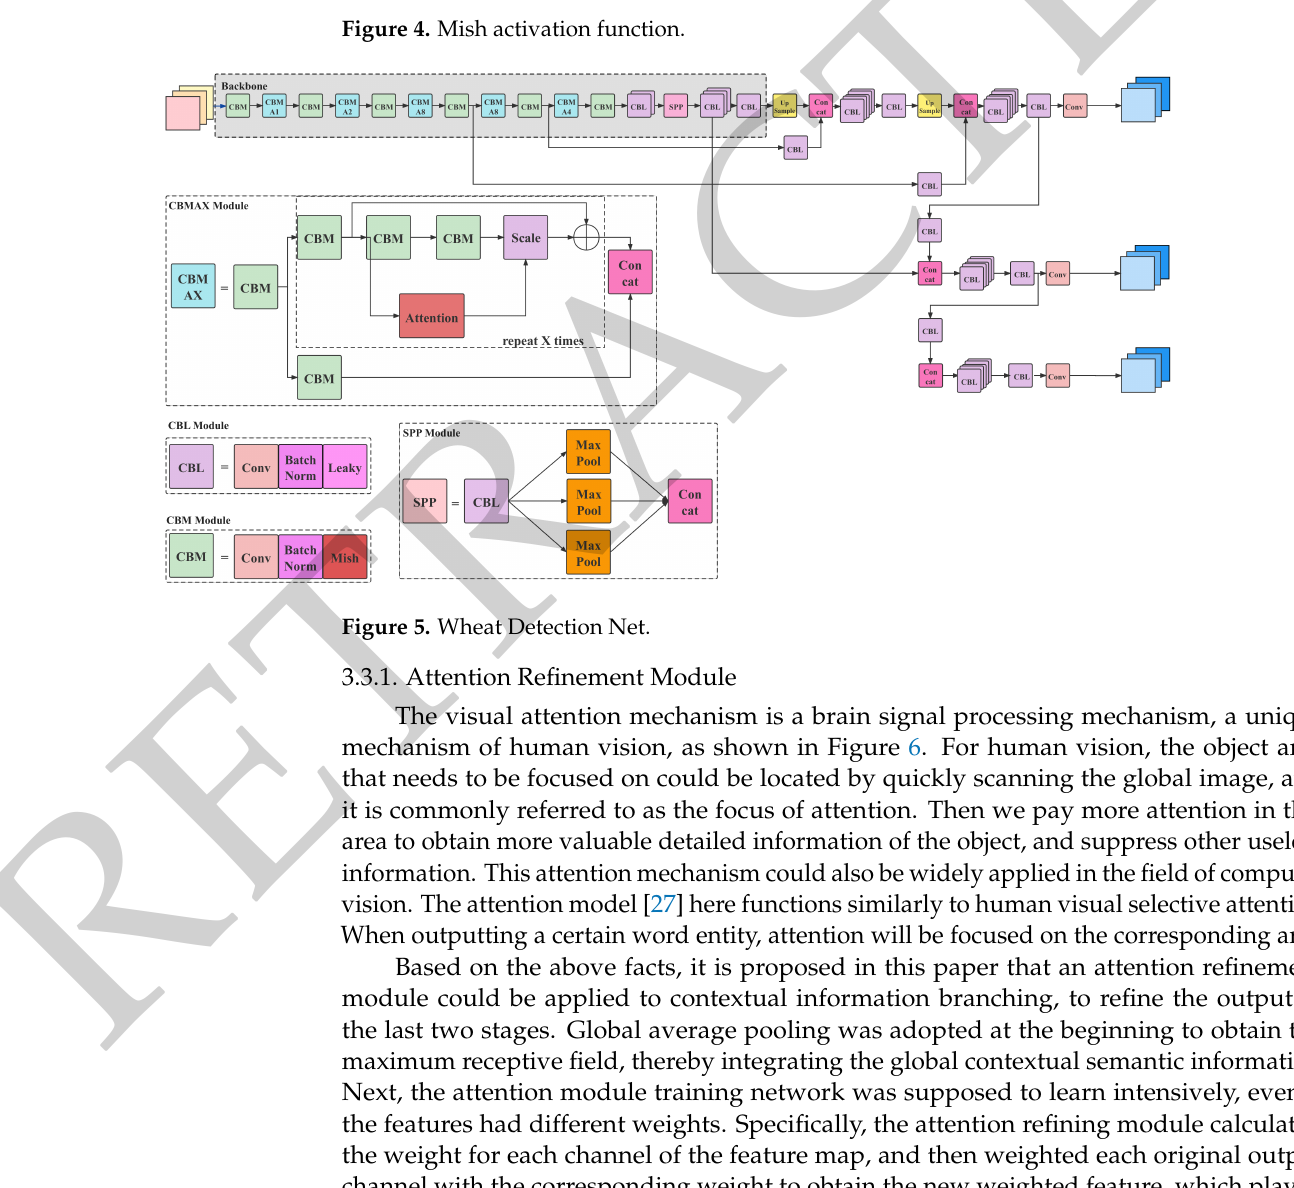
Figure 4. Mish activation function.